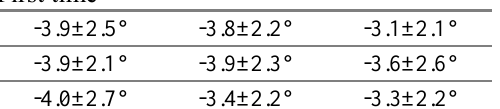
Table 2. Reproducibility of measurements obtained with the